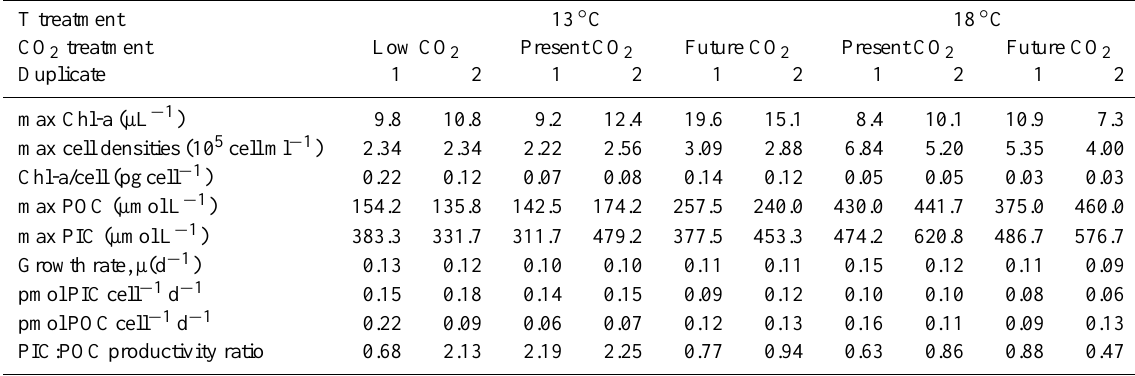
Table 2. Summary of data, other than the DIC chemistry parameters, derived from the culture experiments. T treatment 13 ◦ C CO 2 treatment Low CO